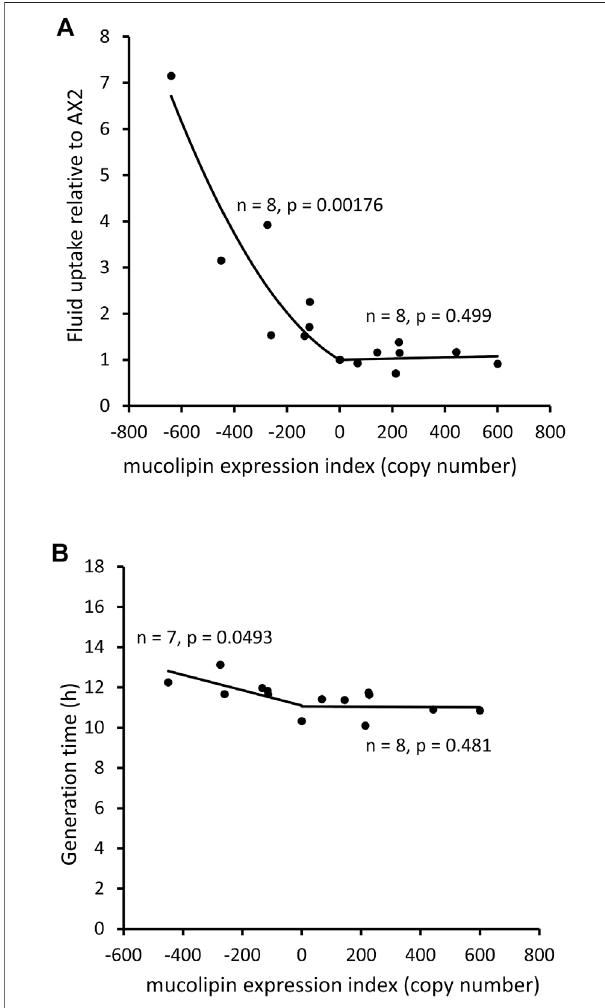
FIGURE 6 | Mucolipin knockdown affects macropinocytic uptake and growth rates of cells in HL5 medium. (A) Consumption of HL-5 medium containing FITC dextran via macropinocytosis in knockdown strains (negative copy numbers),overexpressionstrains(positivecopy numbers)andwild typenormalisedtoAX2.Intheantisensestrains fl uiduptakenormalizedtoAX2 was increased and correlates with mucolipin expression index (Pearson correlation coef fi cient, p = 0.00176), however there was no correlation in the overexpression strains (Pearson correlation coef fi cient, p = 0.499). Each point represents the mean uptake from a single strain. Duplicate samples were assayed for each strain in two to six separate experiments and data was normalised within each experiment to AX2. (B) Generation times (h) of mucolipin strains and AX2 grown in HL5 medium. In the antisense strains generationtimewasincreasedandcorrelateswithmucolipinexpressionindex (Pearsoncorrelationcoef fi cient, p =0.0493),howevertherewasnocorrelation in the overexpression strains (Pearson correlation coef fi cient, p = 0.481). AX2 has a copy number of